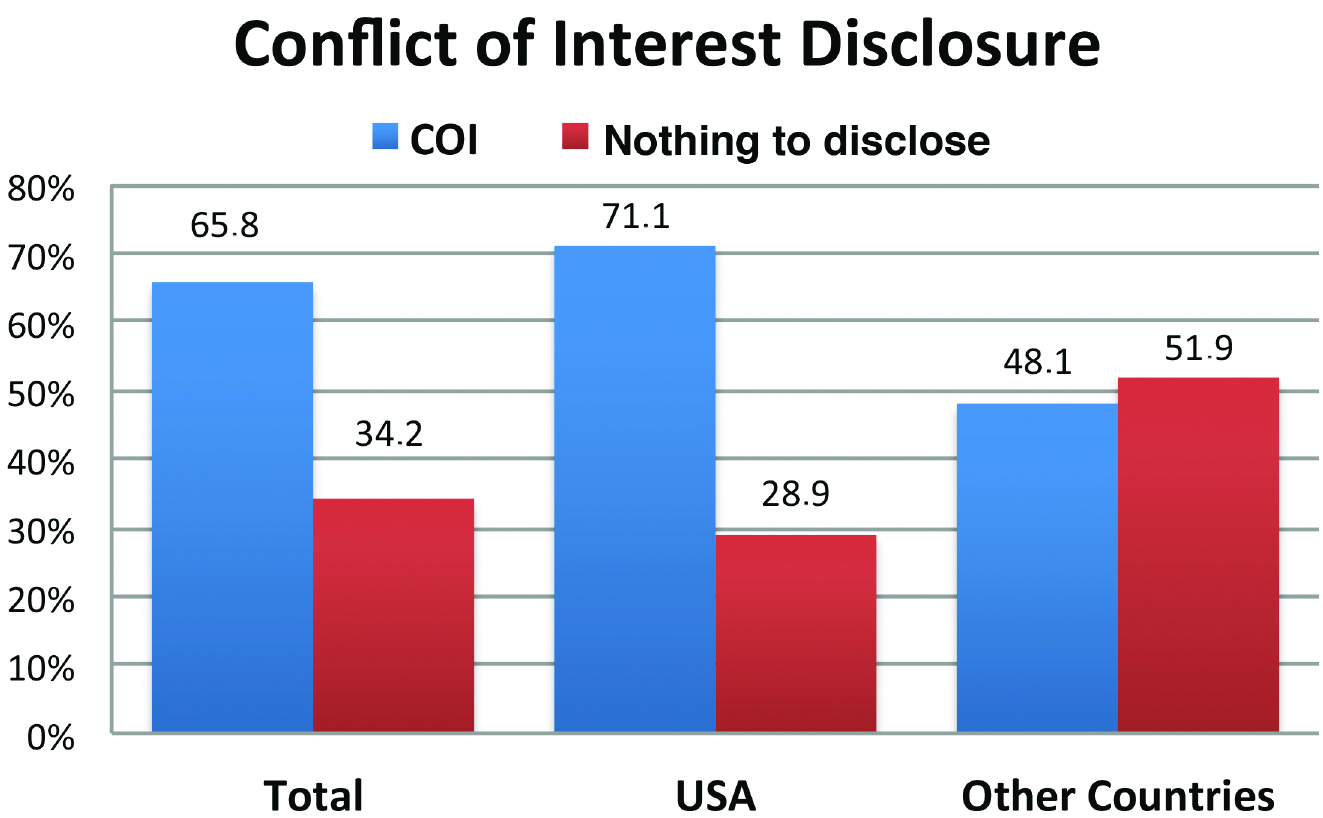
Fig 1. Potential COI disclosed by SRS and IMAST program review members (in percentages) corresponding to the period 2010–2014.